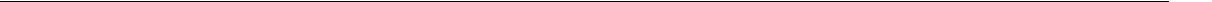
(Supplementary Table S1). Total MDS-UPDRS, HY stage, levodopa/ carbidopa dosage, walking and balance (MDS-UPDRS